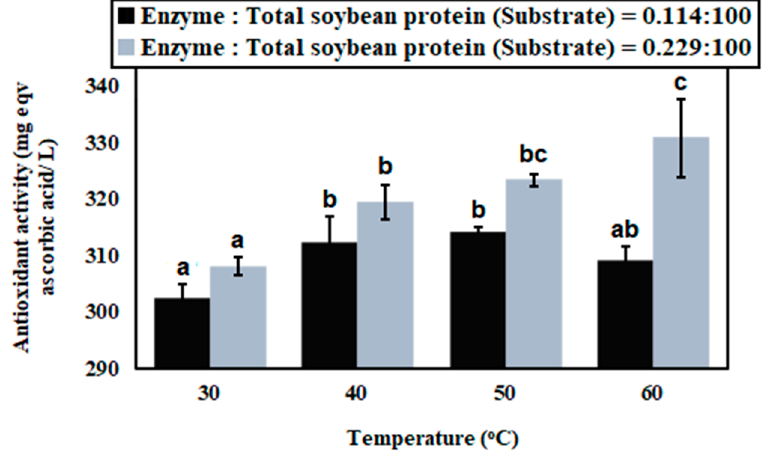
Figure 6. Antioxidant capacity of papain-treated soybean milks, prepared with different concentrations of papain and hydrolysis temperatures.